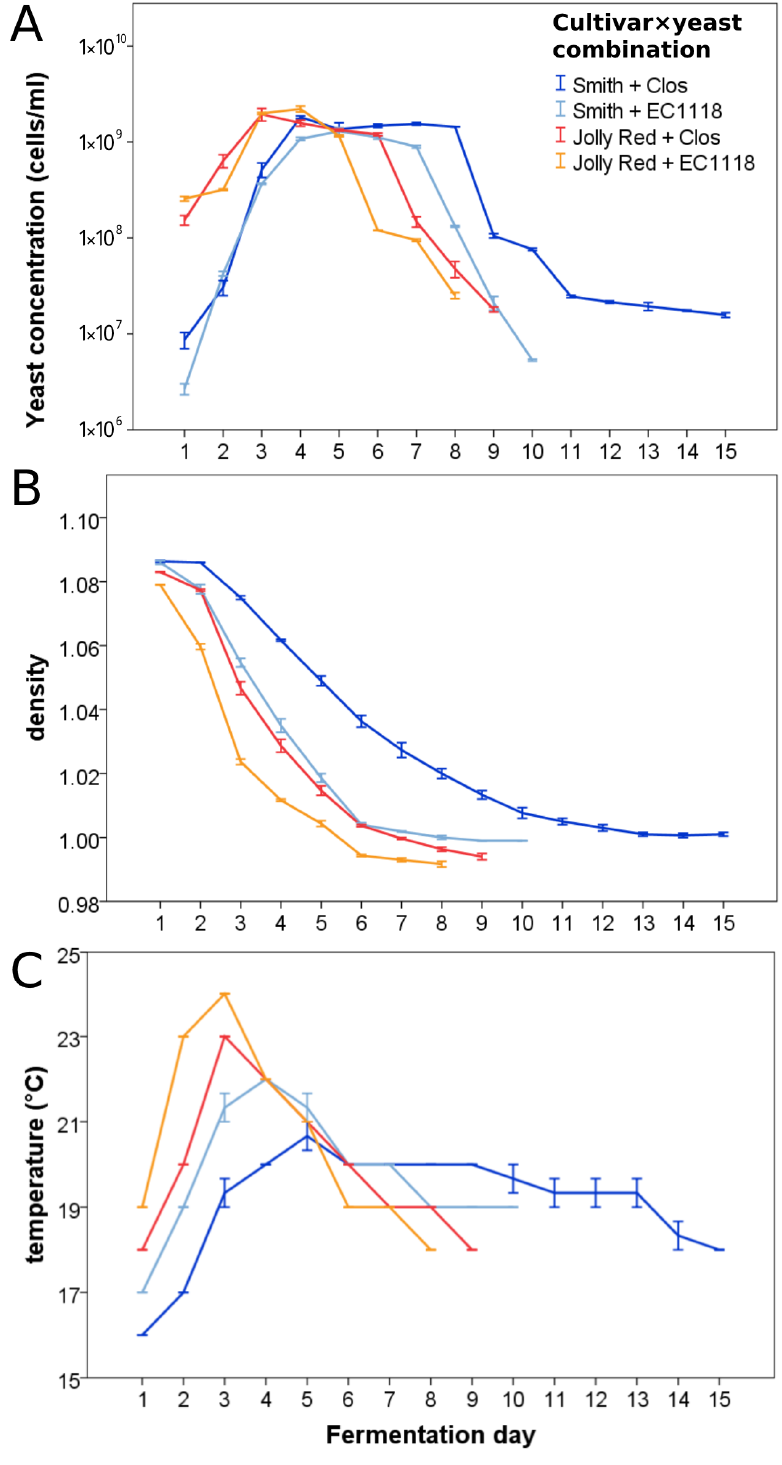
Figure 1. Dynamics of yeast concentrations ( A ), density ( B ), and temperature ( C ) during the fermentation process of pomegranate wines in the four cultivar×yeast combinations tested. Data are averages ± standard errors of three replicates per combination.